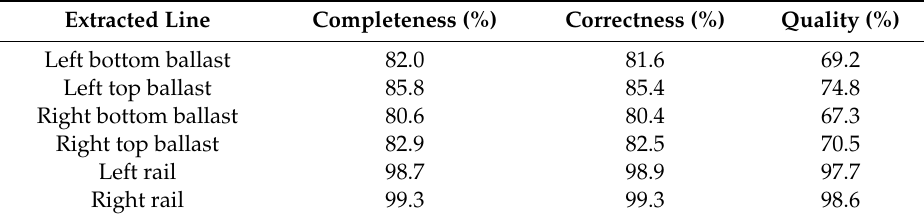
Table 2. Three-dimensional extracted lines accuracy